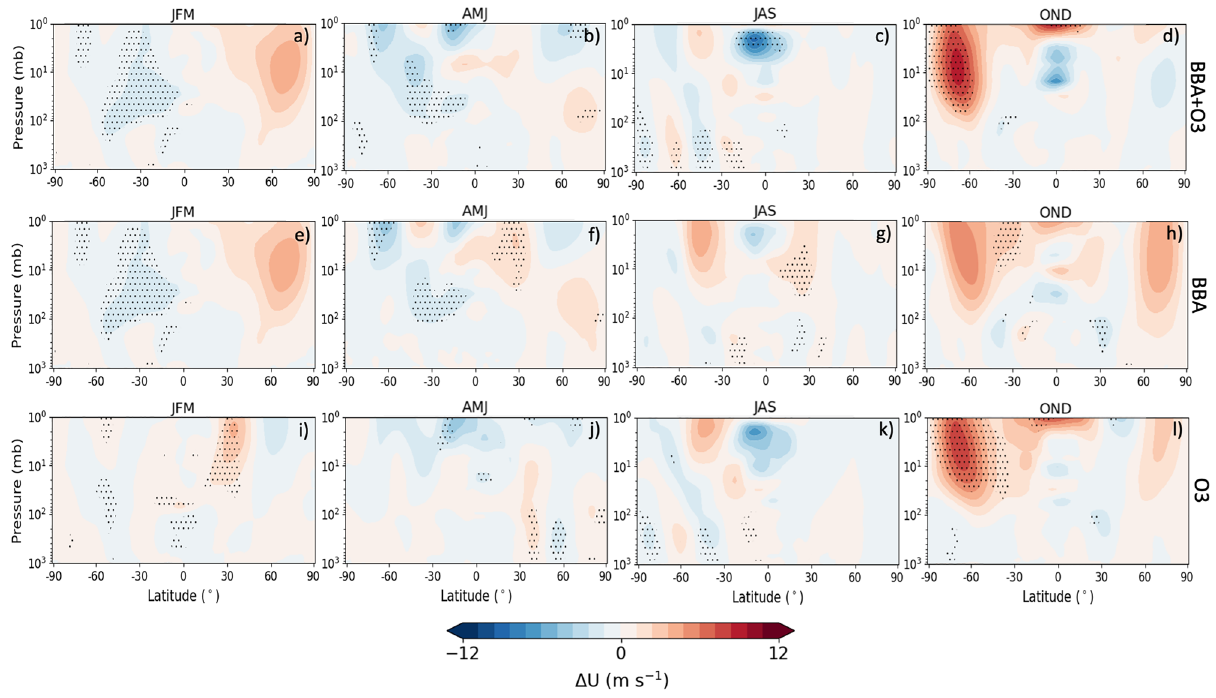
Figure 7. Three-monthly mean modelled perturbations the zonal mean wind (m s −1 ), over all latitudes, due to the smoke aerosol ( e–h ), the ozone anomaly ( i-l ), and both the smoke aerosol and ozone ( a–d ). The stippled points show the points at which the experiments were significantly different from the control simulations at a 5% significance level (calculated by a Welch’s